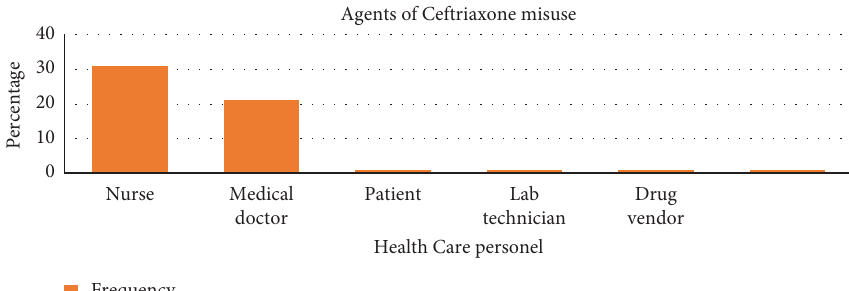
Figure 3: Report of ceftriaxone